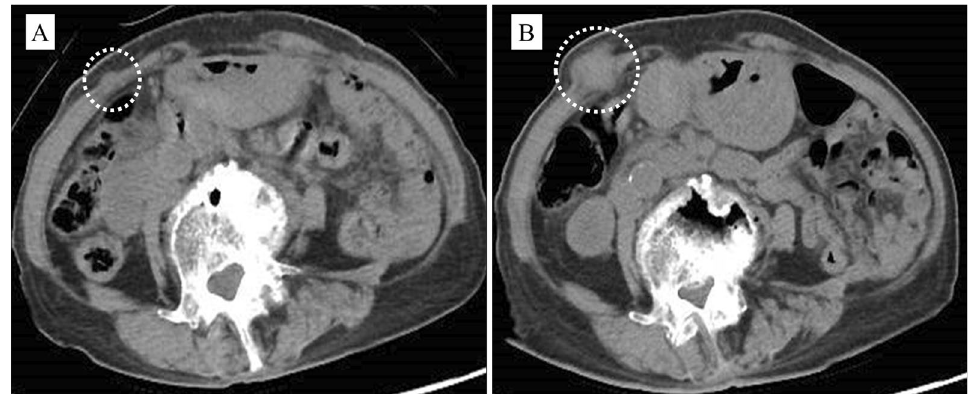
Fig. 2 Computed tomography findings after distal pancreatectomy. A Five months after surgery, an abdominal wall tumor was found in the 5-mm port site in the right hypochondrium. B One year after surgery, the tumor had grown to a diameter of 25 mm. No other intraperitoneal recurrence was detected